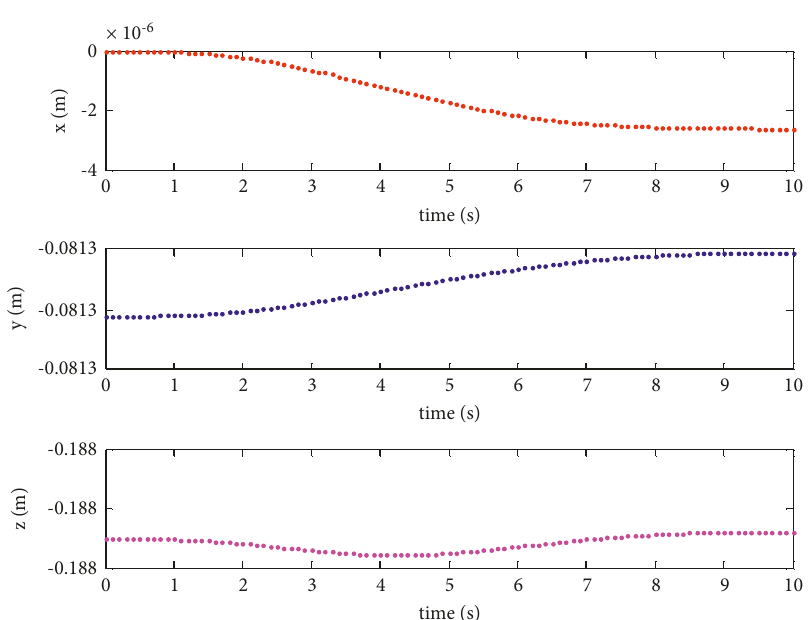
Figure 7: The position of the base obtained by the QPSO